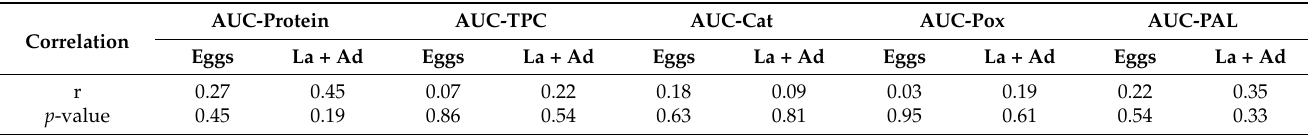
Table 5. Spearman coefficient (r) between egg numbers, larvae (La) + adults (Ad) of Polyphagotarsonemus latus at 15 days after infestation and the area under the curve (AUC) for the leaf protein, total phenolic compounds (TPC), catalase (Cat), peroxidase (Pox) and phenylalanine ammonia lyase (PAL). Londrina-PR,